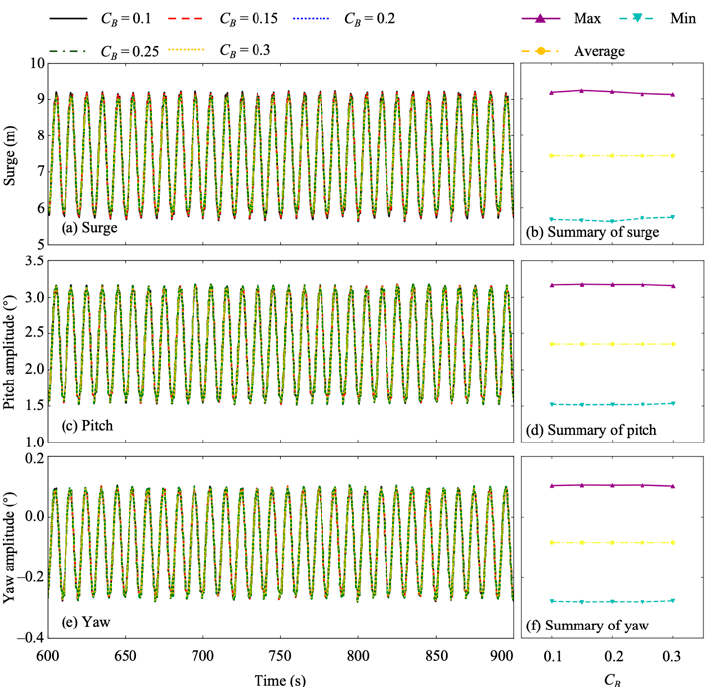
Figure 17. Wind turbine surge, pitch, and yaw movements with different mooring line stiffnesses when under irregular wave case C6: ( a , b ) surge movement; ( c , d ) pitch movement; ( e , f ) yaw movement.